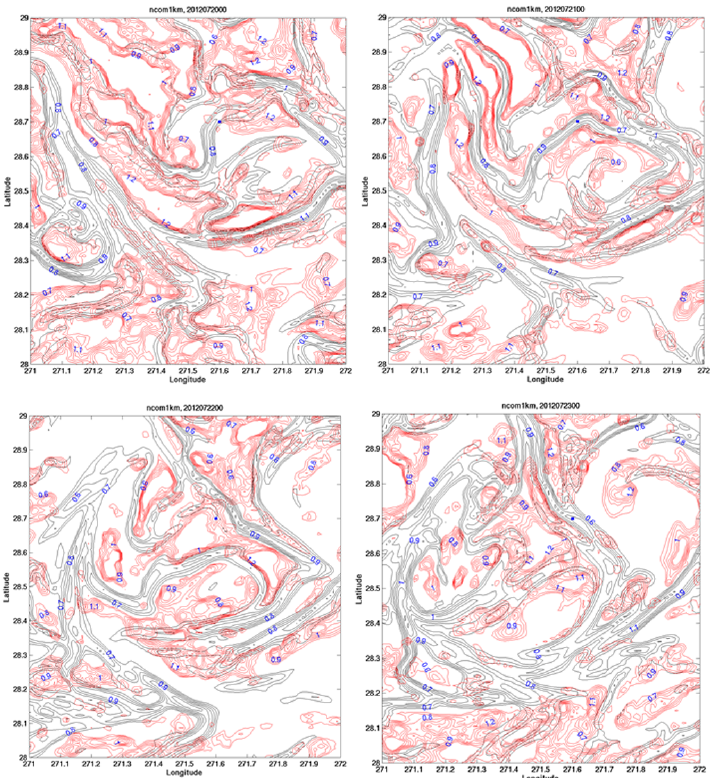
Fig. 14. The repelling (black) and attracting (red) LCSs generated by ncom1km over a small domain near DWH location that is boxed in Figs. 12c and 13c from 20 to 23 July 2012. The DWH location is indicated by the blue